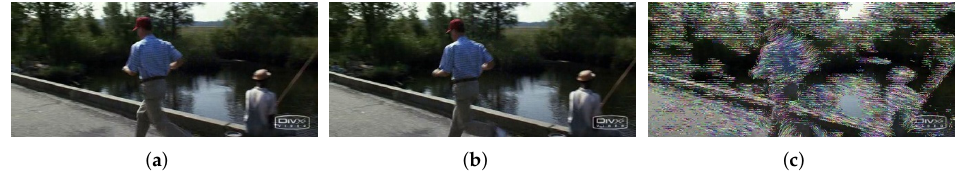
Figure 5. Example of optical flow field. ( a ) Former frame. ( b ) Latter frame. ( c ) Optical flow field.